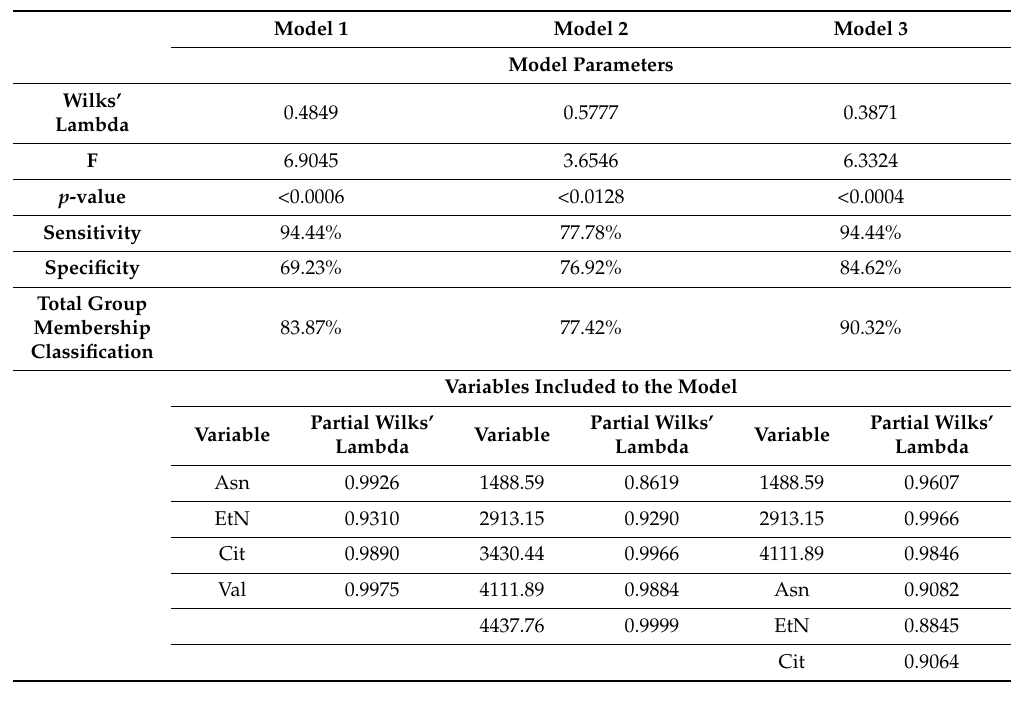
Table 3. Discriminant function analysis. Comparison of the models constructed based on three sets of predictor